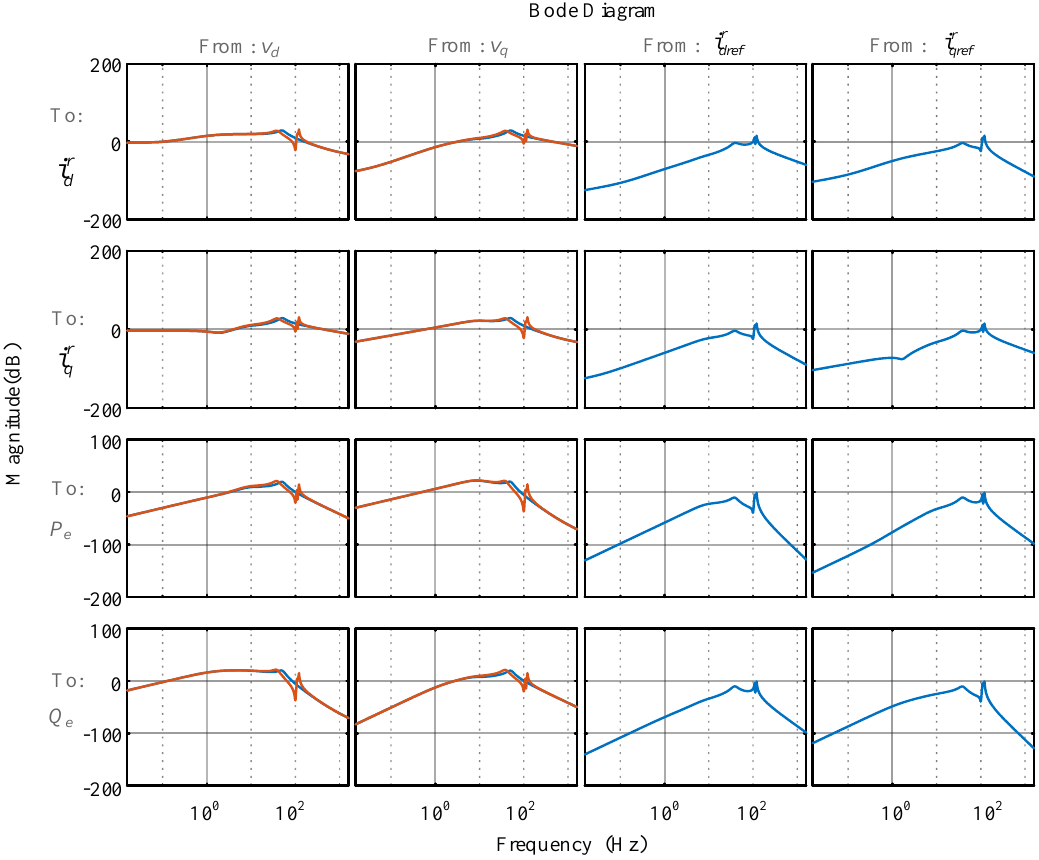
Figure 7. Bode diagram illustrating the effect of proposed resonant controller. Blue line: modified synchronverter with additional resonant controller. Red line: conventional synchronverter.